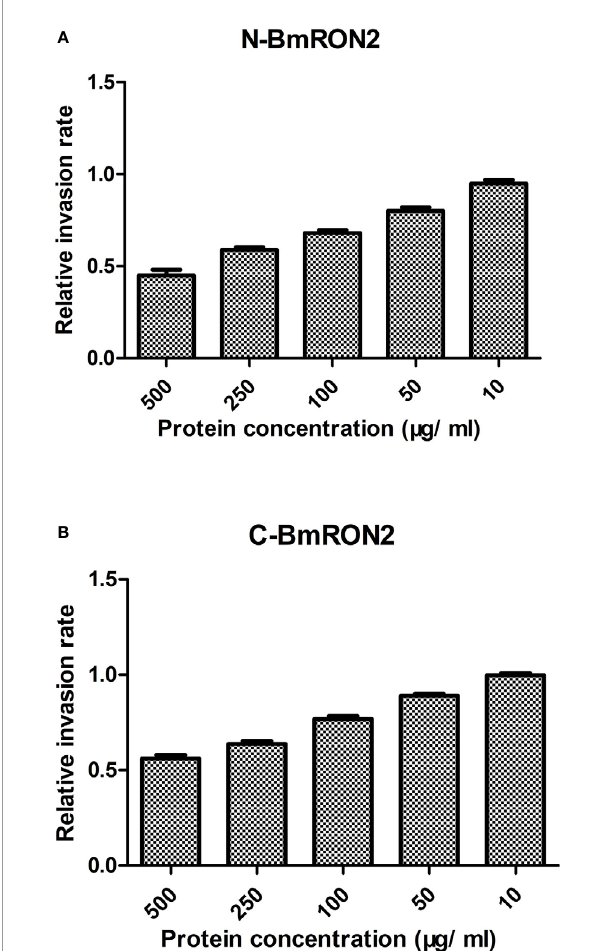
FIGURE 4 | In vitro inhibition of red blood cell invasion by B. microti rBmRON2 proteins. Inhibitory effects of rN-BmRON2 and rC-BmRON2 on red blood cell invasion. Recombinant proteins were added to the culture medium at concentrations between 10 and 500 m g/mL. rN- BmRON2 (A) and rC- BmRON2 (B) showed a dose-dependent inhibitory